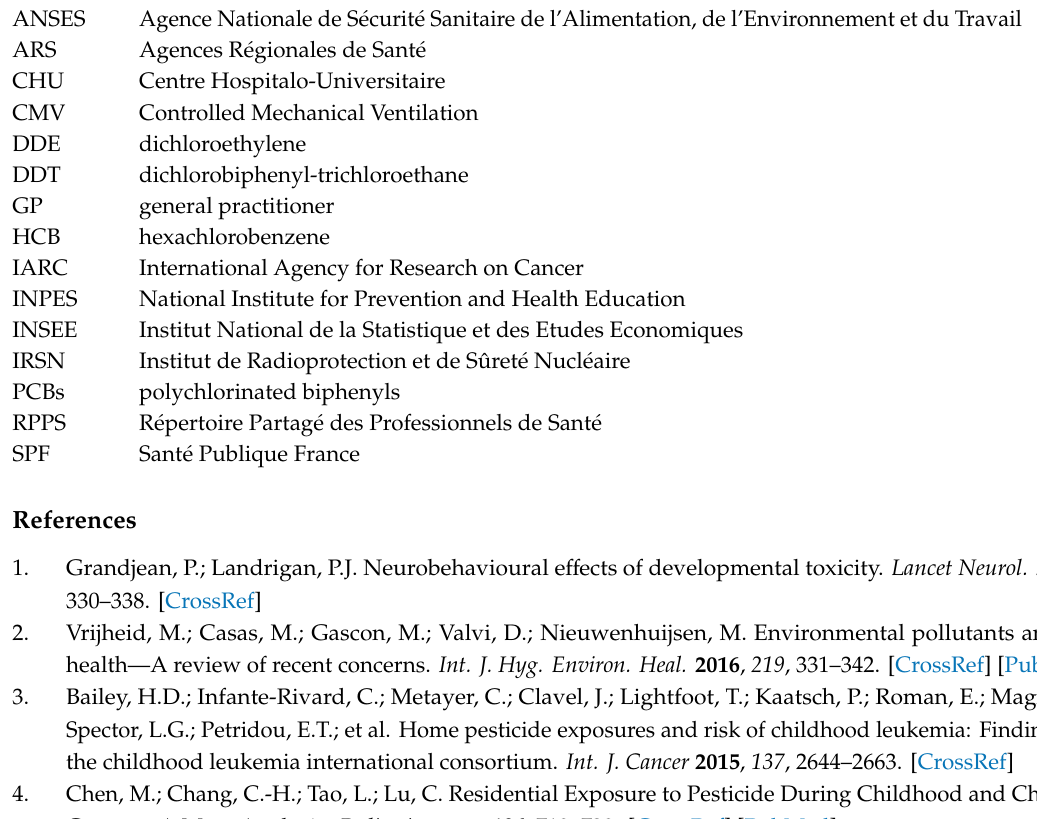
Document S1: Questions exploring practices, Table S1: Practice on air renewal according to socio-demographic ( n = 554), Table S3: Hygiene products and cosmetics use according to socio-demographic characteristics ( n = 554), Table S4: Pratices on textile according to socio-demographic characteristics ( n = 554), Table S5: Use and choice of cleaning products ( n = 554), Table S6: Attitude during renovation in a children room according to socio-demographic characteristics ( n = 554), Table S7: Practice on indoor air according to perceptions ( n =